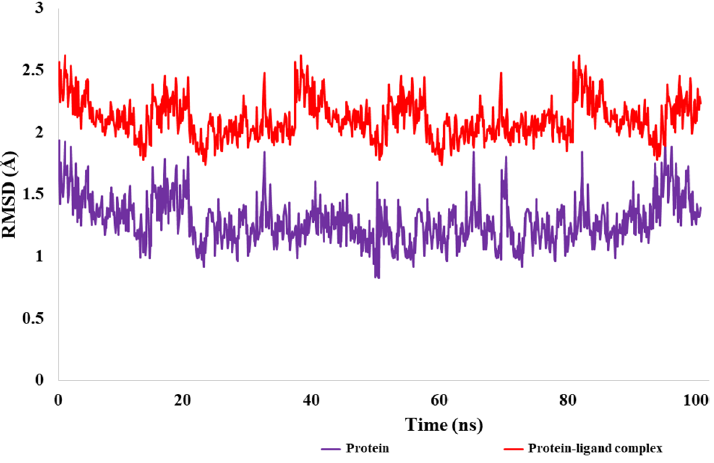
Figure 7. Root mean square deviation [RMSD] graph against time for Urease- 4i complex. Peaks in the RMSF show residues of the protein that fluctuate during the simulation. Usually, the tail (N and C terminal) of the protein changes more than other parts. The residues with higher peaks are found in the N and C terminal zones, according to MD trajectories (Figure 8). The stability of the ligand–protein interaction is shown by the low RMSF values of the binding site residues.